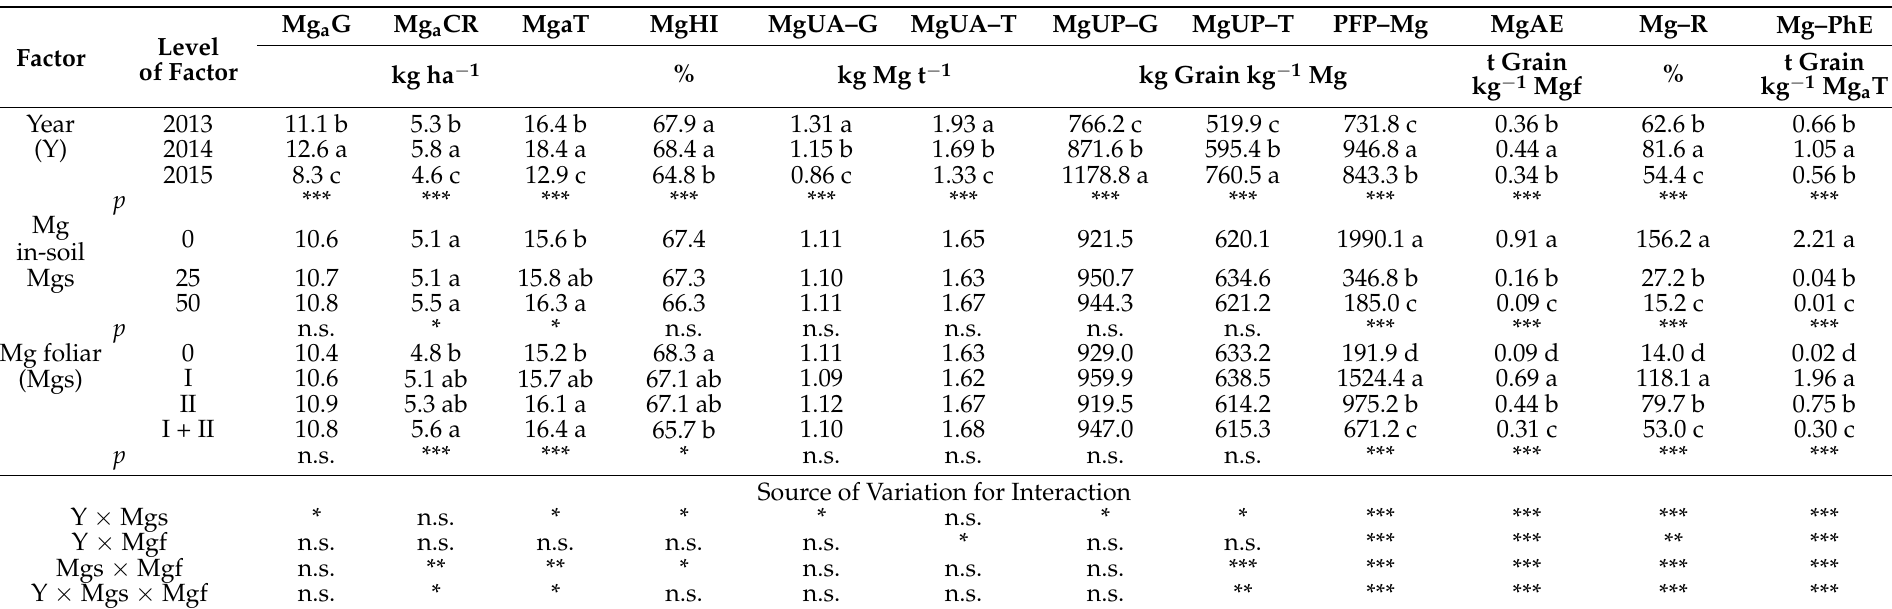
Table 1. Magnesium uptake by winter wheat at maturity and indices of magnesium use